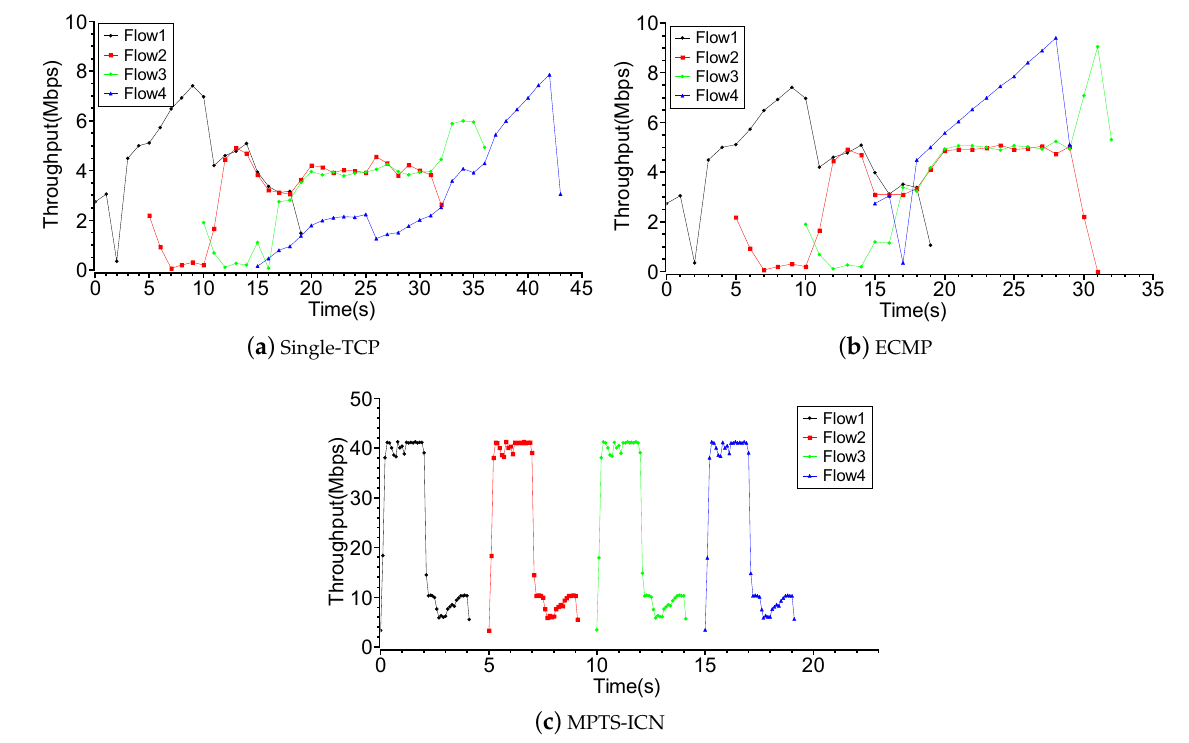
Figure 12. Throughput under different data transmission schemes. ( a ) The variation trends of the throughput under the Single-TCP scheme. ( b ) The variation trends of the throughput under the ECMP scheme. ( c ) The variation trends of the throughput under the MPTS-ICN scheme.